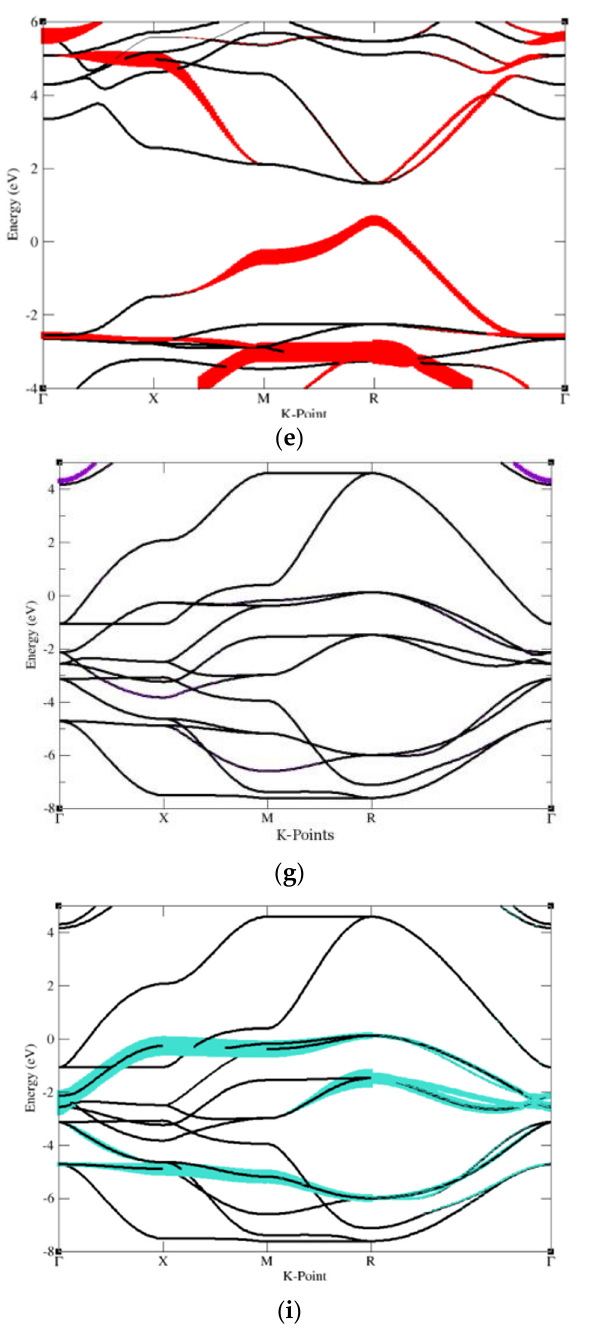
Figure 4. Fat band of halide and oxide perovskite, the main contribution of each atom contained in cubic perovskite structure graphed out separately. These graphs are drawn for the purpose of sufficiently observing the main contribution of the atoms contained in the structure in order to adjust the energy bandgap. ( a ) Cs atom contained in CsSnCl 3 ( b ) Sn atom contained in CsSnCl 3 , ( c – e ) Cl atom contained in CsSnCl 3 . ( f ) Sr atom of SrRhO 3 , ( g ) Rh atom of SrRhO 3 , ( h – j ) O atom of SrRhO 3 .